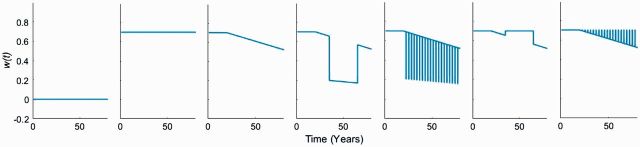
Examples of different immune system activity across ages (0–80 years). First column (a1 = 0), second column (a1 = 0.7, a2 = 0), third column (a1 = 0.7, b0 = 20 years, a2 = 3×10 −3), fourth column (a1 = 0.7, b0 = 20 years, a2 = 3×10 −3, a3 = 0.7; total duration = 30 years), fifth column (a1 = 0.7, b0 = 20 years, a2 = 3×10 −3, a3 = 0.7; total duration = 4 years, 20 episodes of 70 days), sixth column (a1 = 0.7, b0 = 20 years, a2 = 3×10 −3, a3 = −0.7; total duration = 30 years), seventh column (a1 = 0.7, b0 = 20 years, a2 = 3×10 −3, a3 = −0.7; total duration = 4 years, 20 episodes of 70 days)